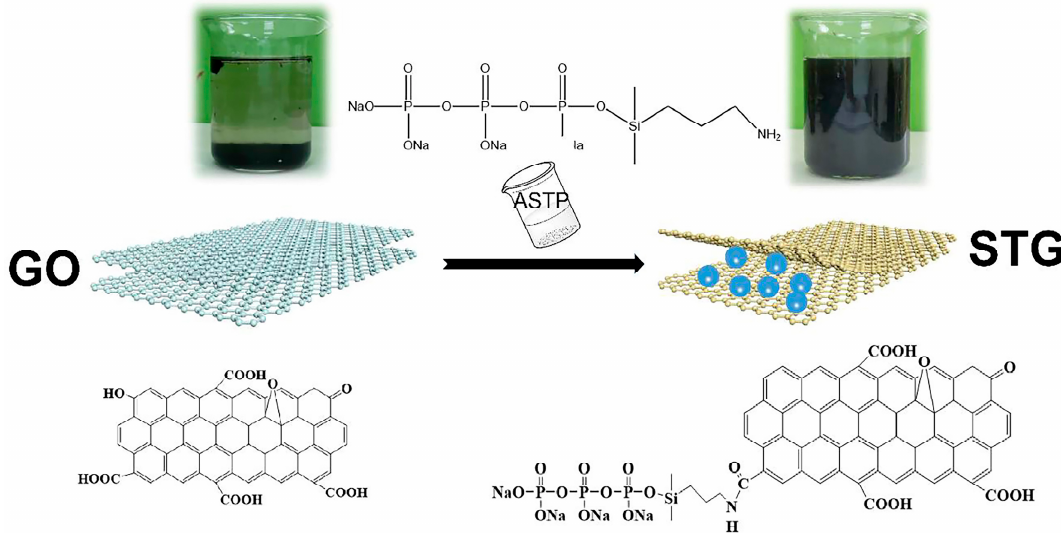
Figure 1. Schematic diagram of the integration of sodium tripolyphosphate with graphene oxide.